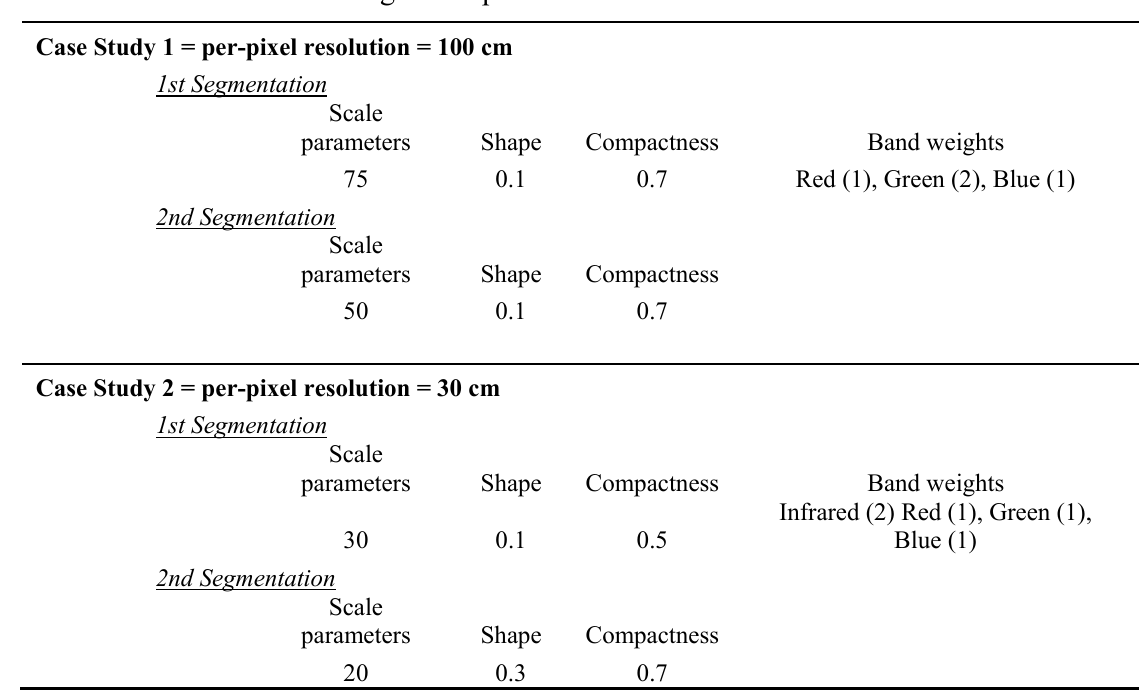
Table 3. Algorithm parameters for Case Studies 1 and